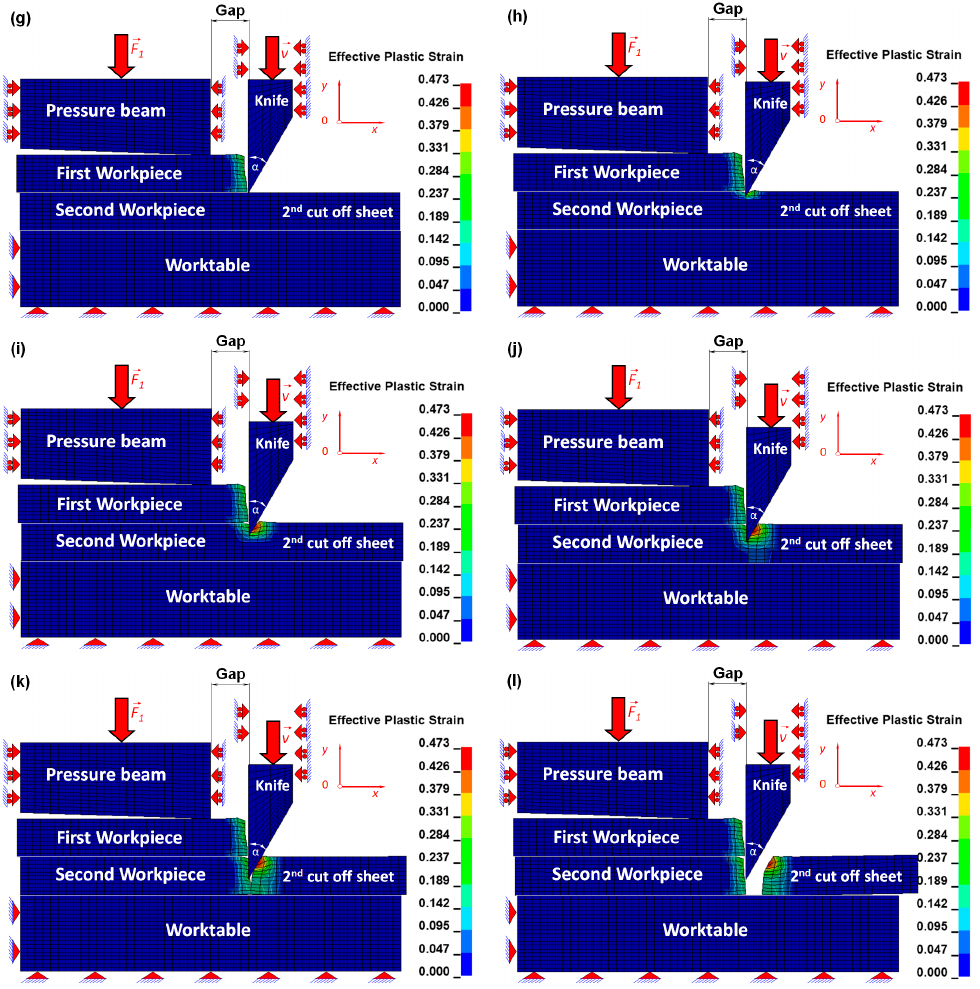
Figure 7. Effective plastic strains in the second sheet being cut for the following time instances: ( g ) t = 7.5 s, ( h ) t = 8 s, ( i ) t = 9 s, ( j ) t = 9.5 s, ( k ) t = 10.1 s, ( l ) t = 10.11 s (continuation of Figure 6). The effective